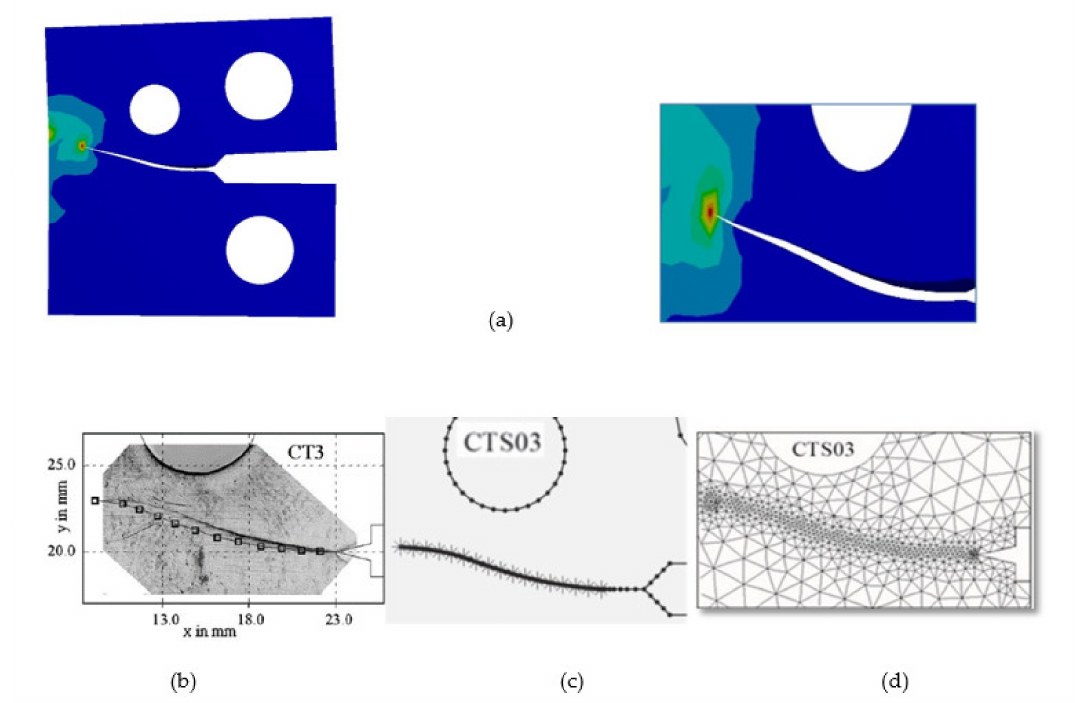
Figure 8. The predicted crack path of CTS03 ( a ) present study, ( b ) experimental and numerical results of [24], ( c ) BemCracker2D [41] and ( d ) Quebra2D [41].